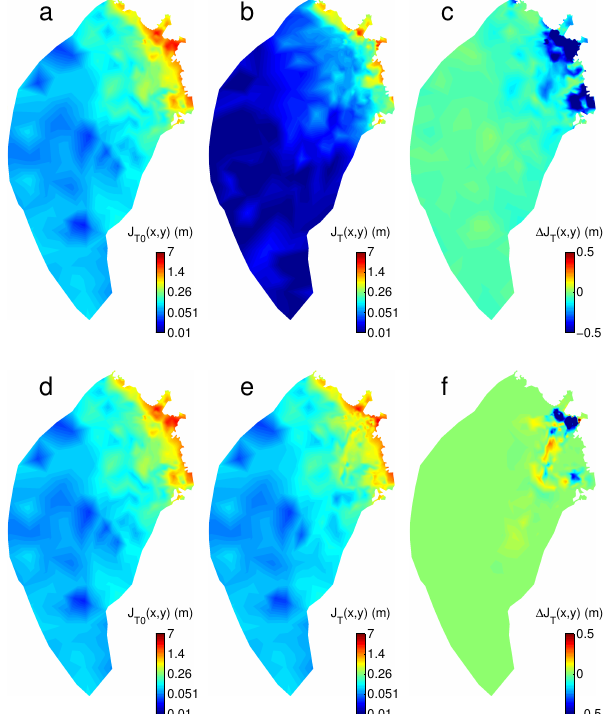
Fig. 8. a) and d): localized misfit J T 0 ( x,y ) as defined in Eq. (9) before inversion of surface mass Figure 8. (a and d) Localized misfit J T 0 (x,y) as defined in Eq. (9) balance M s and basal friction α respectively. b) and e): localized misfit J T ( x,y ) after inversion. c) before inversion of surface mass balance M s and basal friction α , and f): corresponding decrease in localized misfit ∆ J T ( x,y ) = J T ( x,y ) respectively. (b and e) Localized misfit J T (x,y) after inversion. inversion. (c and f) Corresponding decrease in localized misfit (cid:49)J T (x,y) = J T (x,y) − J T 0 (x,y) before and after